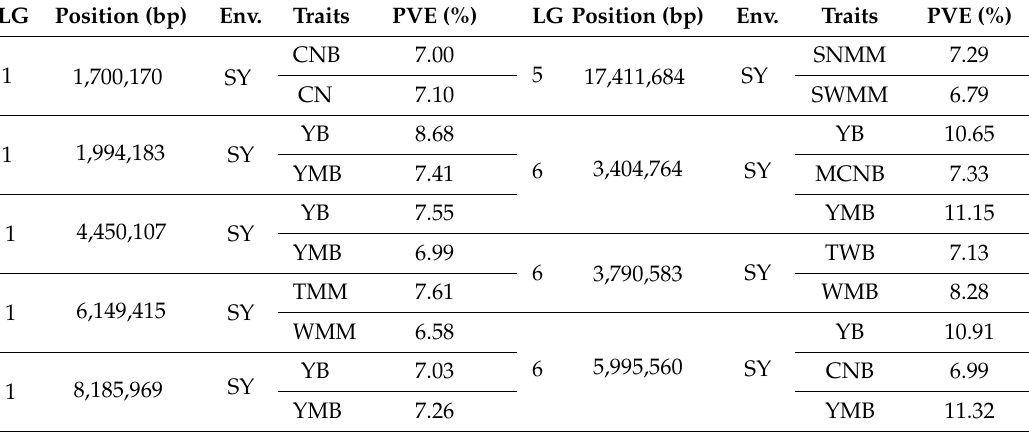
Figure 2. Correlation between all the seed yield-related traits in sesame. Blue color depicts positive correlation while red color means negative correlation. A, B and C correspond to the clusters of traits. Definition of the labels can be found at the end of this article. Table 1. SNPs stably detected in different environments and for various